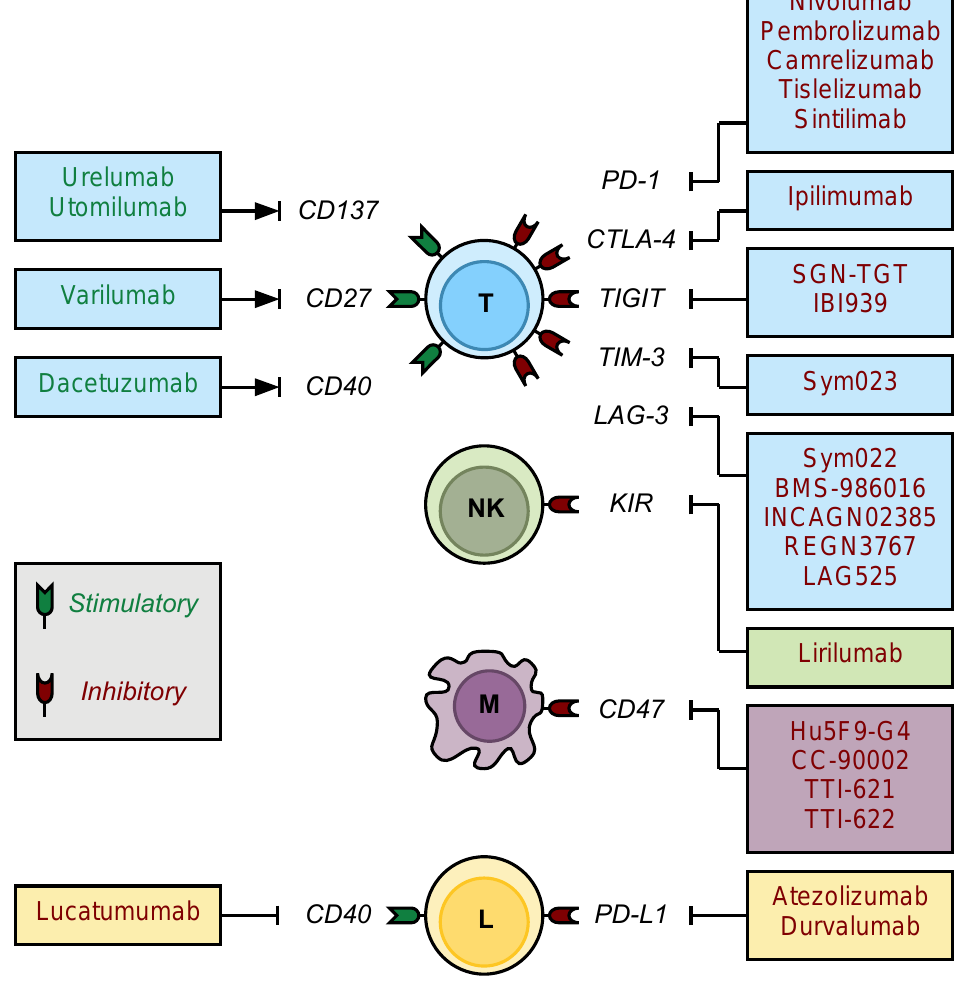
Figure 3. Immune checkpoint inhibitors and stimulators in lymphoma. Numerous checkpoint inhibitors and stimulators are in clinical use or under investigation in lymphomas. Putative targets on T-cells (T), natural killer cells (NK), tumor-associated macrophages (M), and lymphoma cells (L) have been identified. Green shading and text denote stimulatory receptors and antibodies, respectively. Likewise, red shading and text denote checkpoint inhibitor proteins and antibodies, respectively.